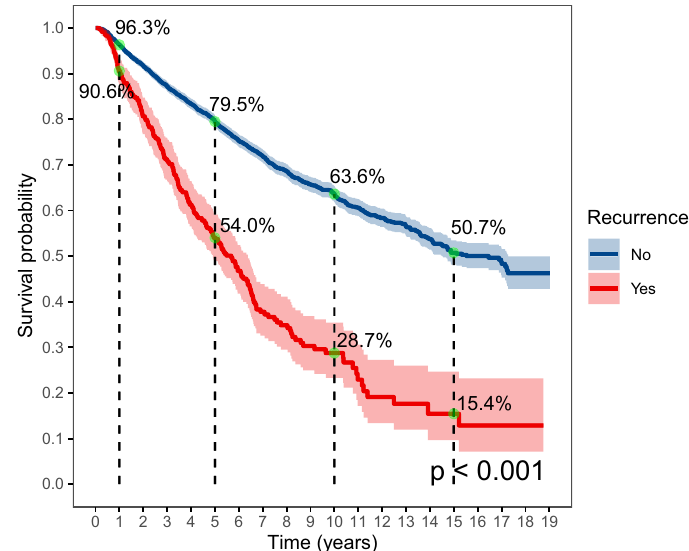
Figure 3. The overall survival probability by recurrence.